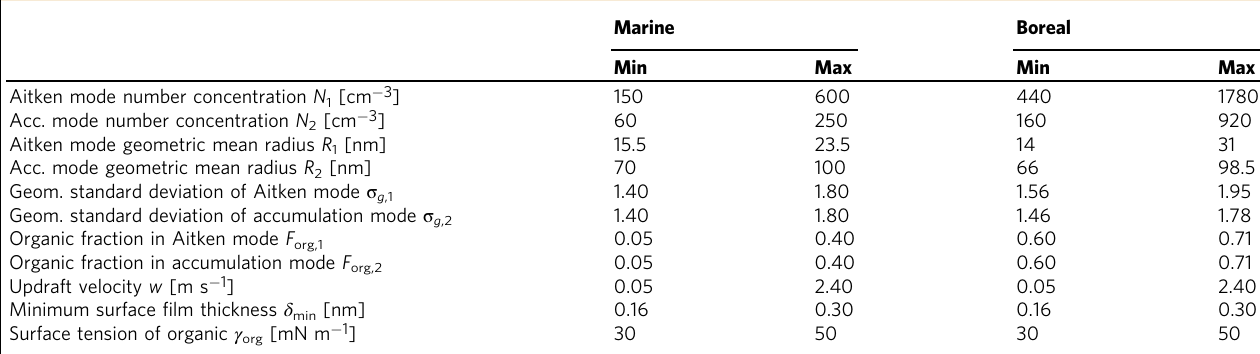
Table 2 Parameter ranges bounding Latin hypercube sampled 38 random parameter combinations used for cloud parcel model input in assessing parametric uncertainties in model